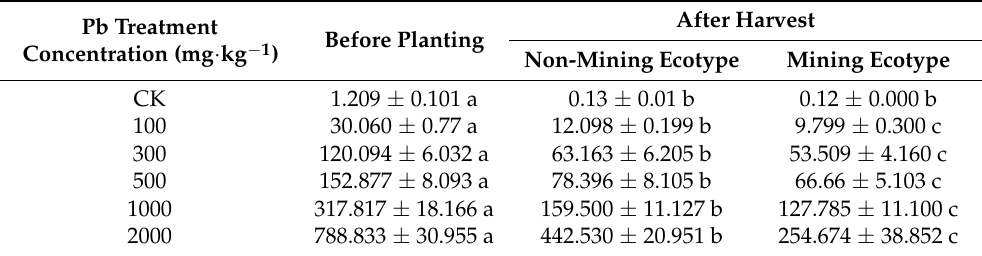
Table 2. Concentration of ammonium acetate-extractable Pb (NH 4 OAc-Pb) in soils before and after planting Miscanthus floridulus (mg · kg − 1